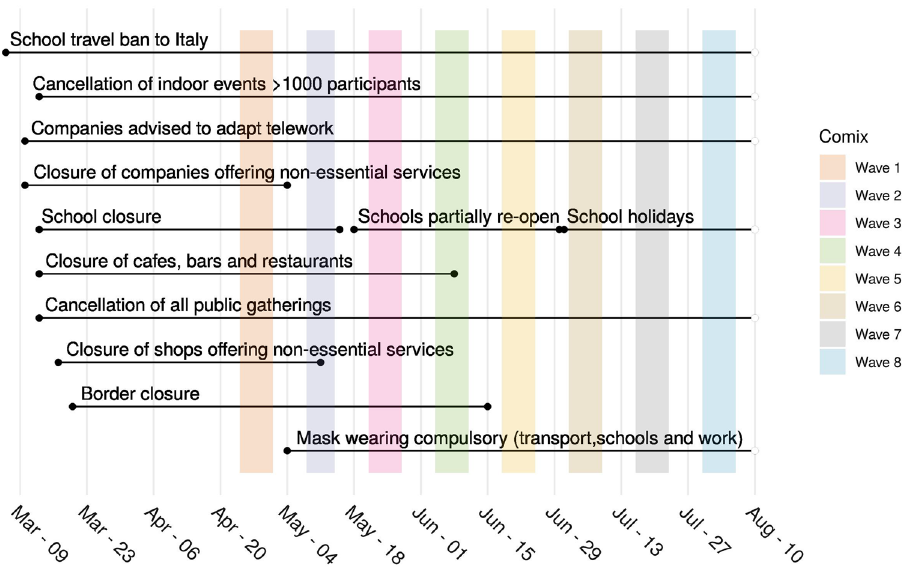
Figure 6. Calendar of interventions and CoMix wave data